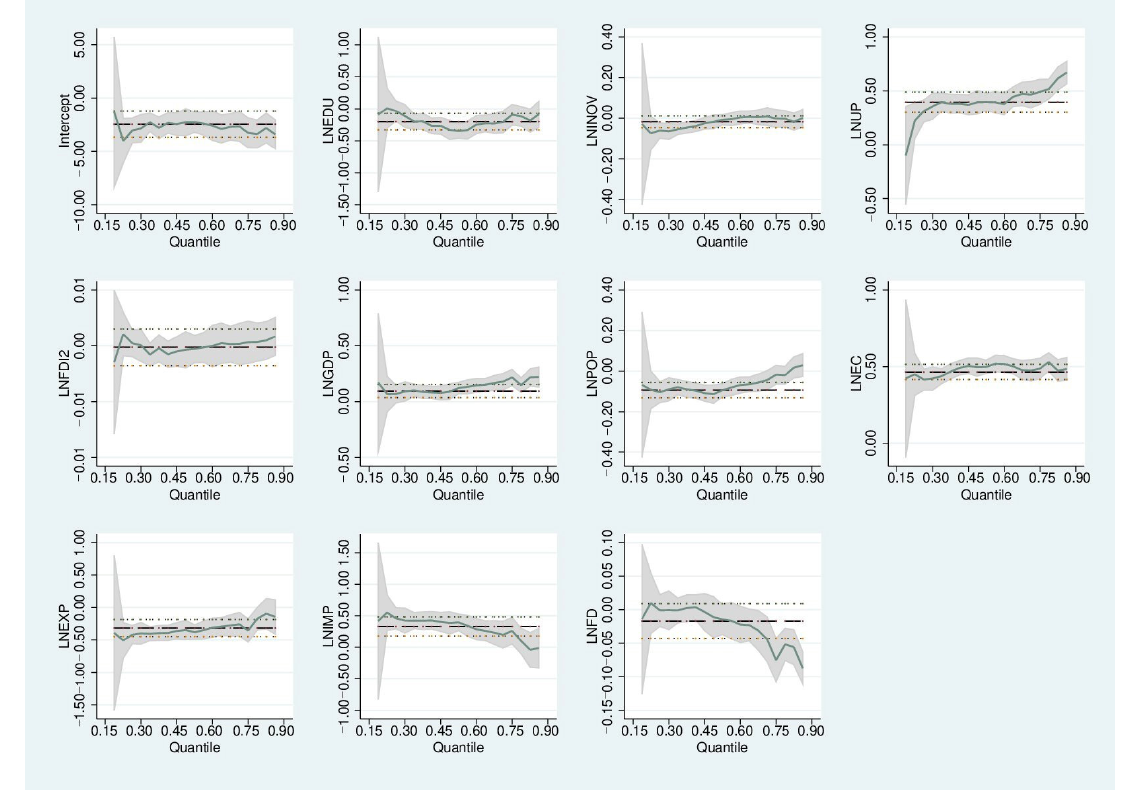
Figure 3. Quantile Distribution for High-Income Countries.